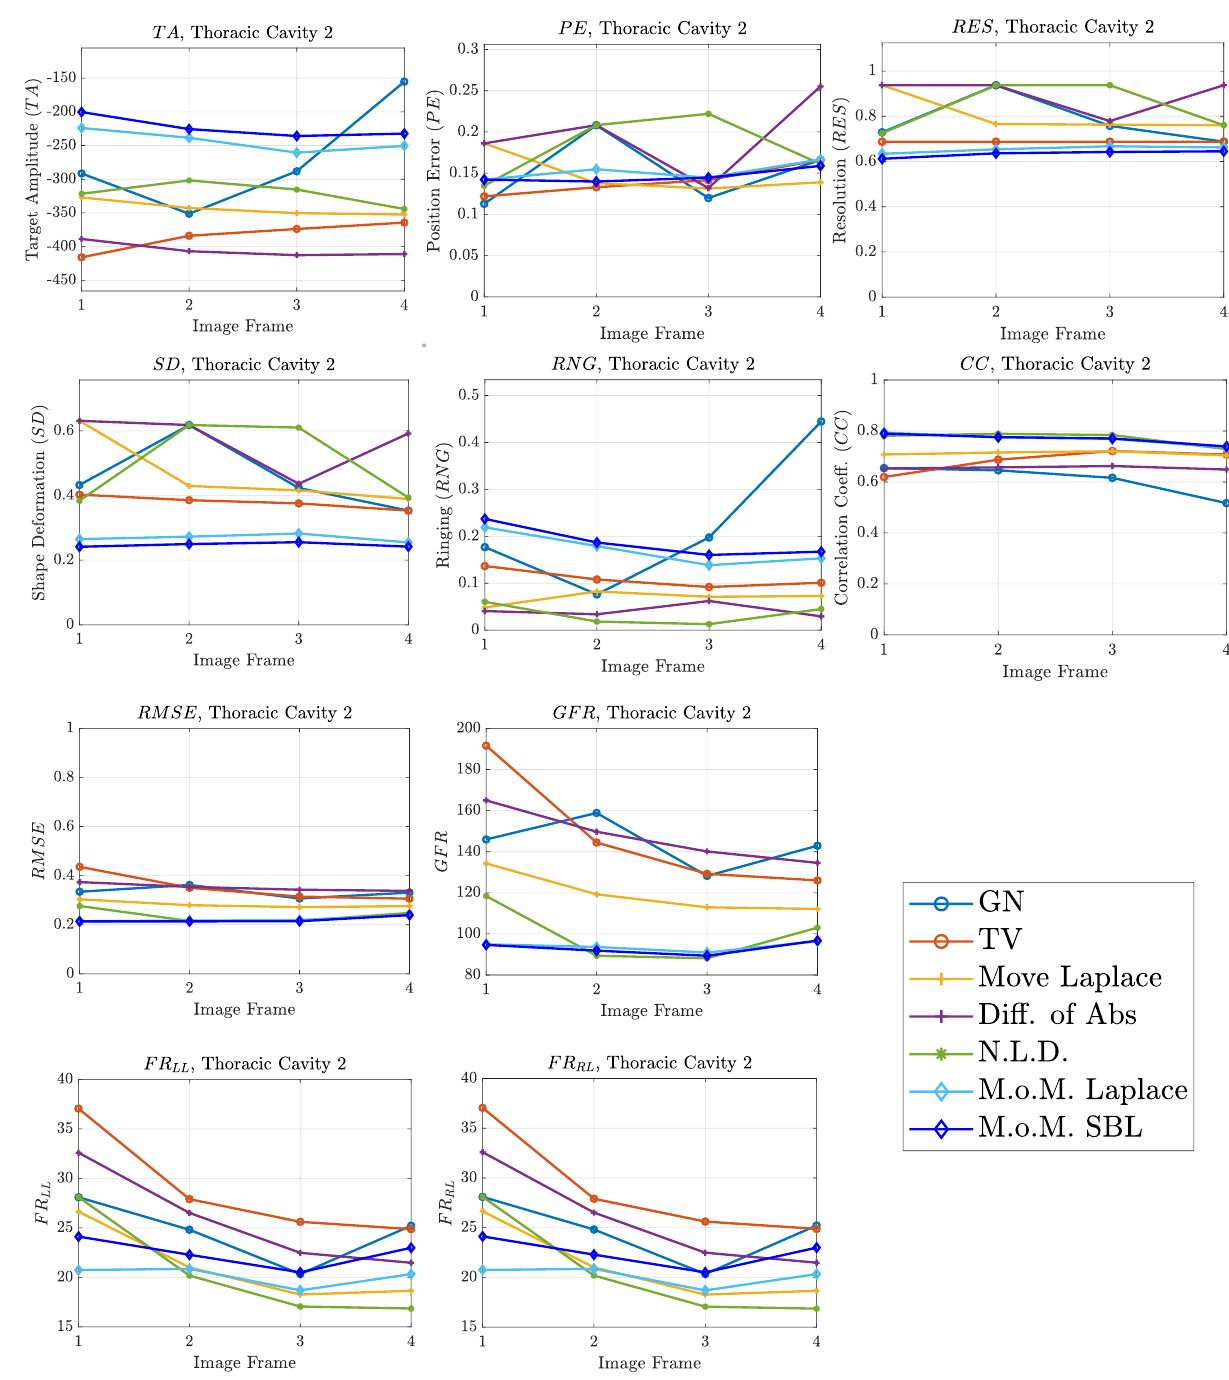
Figure 12. FoM results for the second